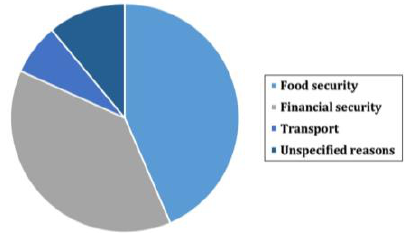
Fig. 3. Reasons for keeping livestock (Source: own elaboration)